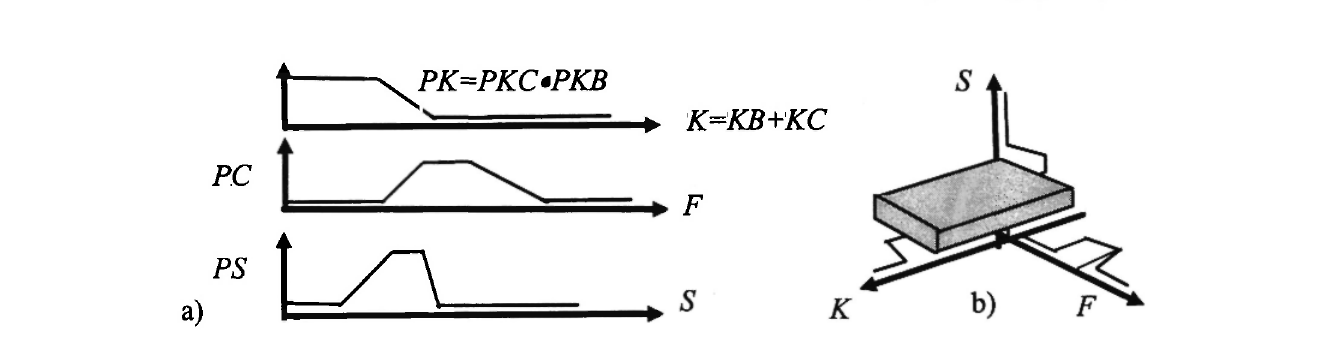
Fig. 5: The satisfaction functions: a) Satisfaction function PK of the cost K, satisfaction function PC of the cone failure criterion F and satisfaction function PS of beam stress ratio S, b) design